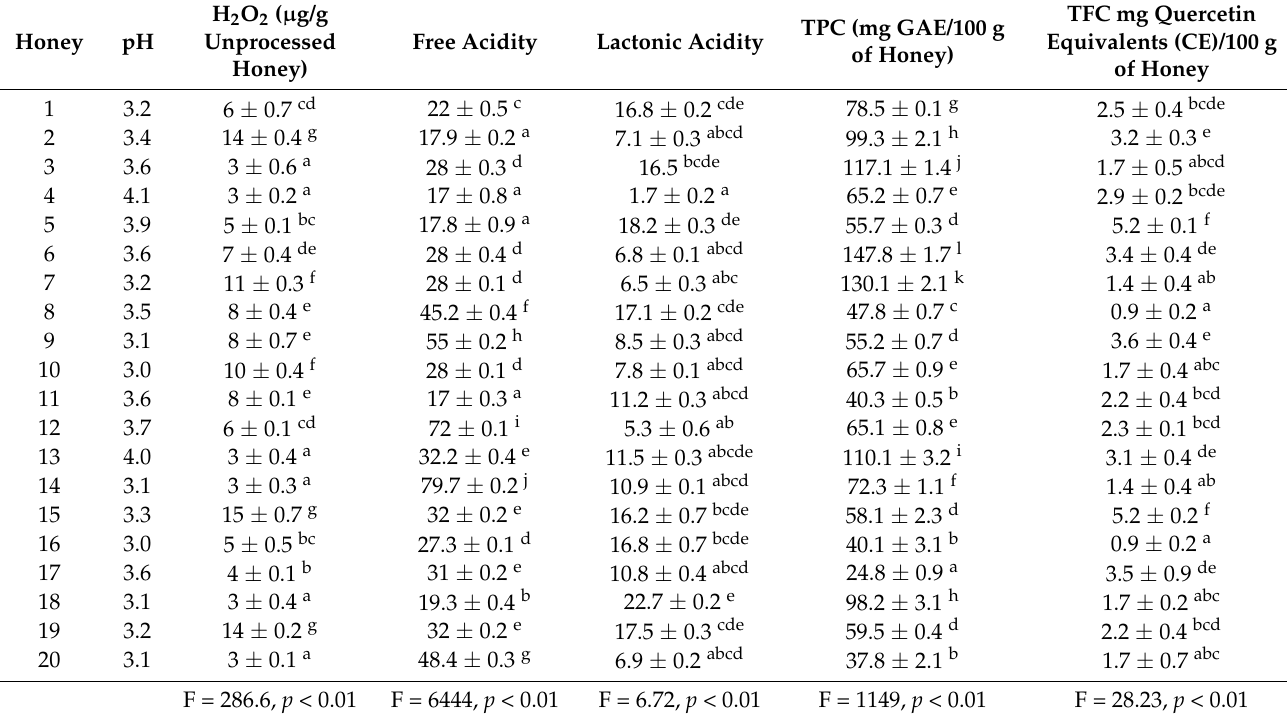
Table 4. Physicochemical characteristics of the 20 honey Satureja spp. samples.